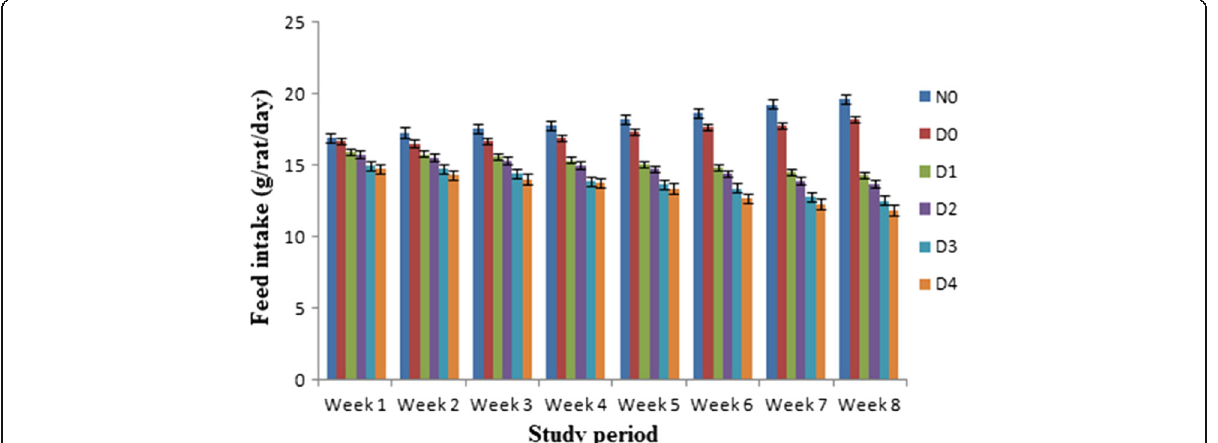
Fig. 1 Feed intake (g) in normal and diabetic rats during 8 weeks (rat/week). Results are expressed as amount of feed intake levels of diabetic and non-diabetic rats (mean ± standard deviation (SD). n = 10). The feed intake of diabetic rats (D 1 , D 2 , D 3 and D 4 ) received stevia aqueous extract in different concentrations (200, 300, 400 and 500 ppm) respectively significantly ( P < 0.05) decreased from non-diabetic (N 0 ) and diabetic (D 0 ) control groups